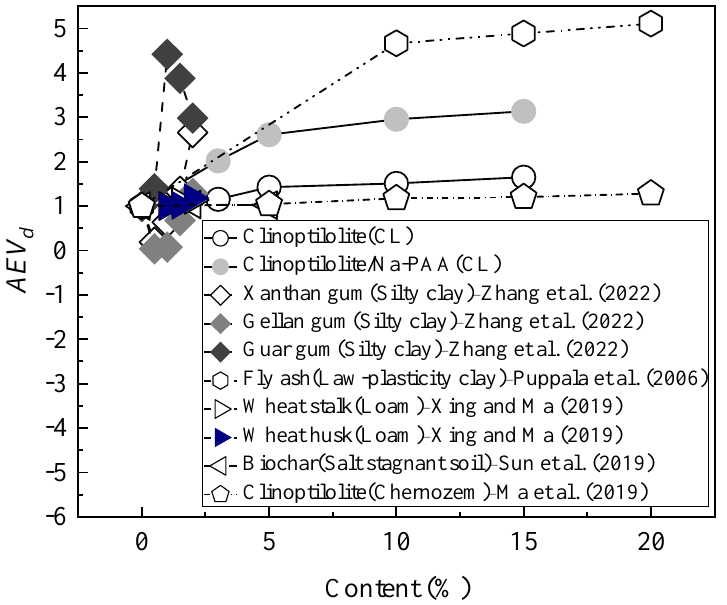
Figure 14. Influence of different water-retaining agents on air− entry value ( AEV d ) [55,59 −62] .